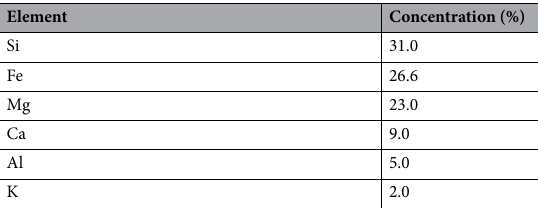
Table 3. Concentrations (%) of the main elements making up the debris accumulated in the hollow region of coin D. The values were obtained from the best fit of a single XRF spectrum collected on the same spot for 300 s. Uncertainties are ± 0.5% .